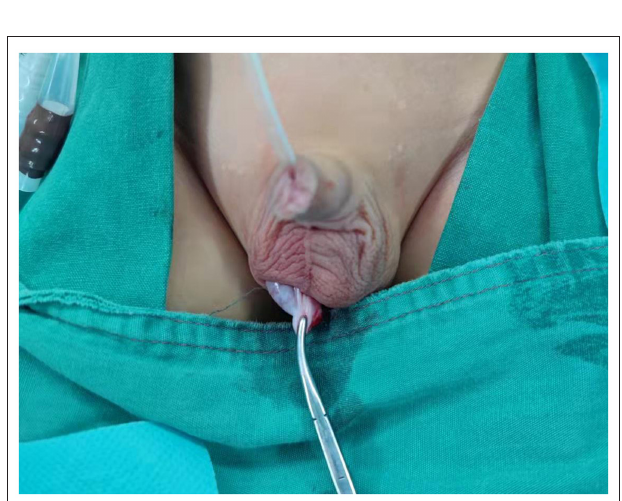
FIGURE 2 | The testis descended into the